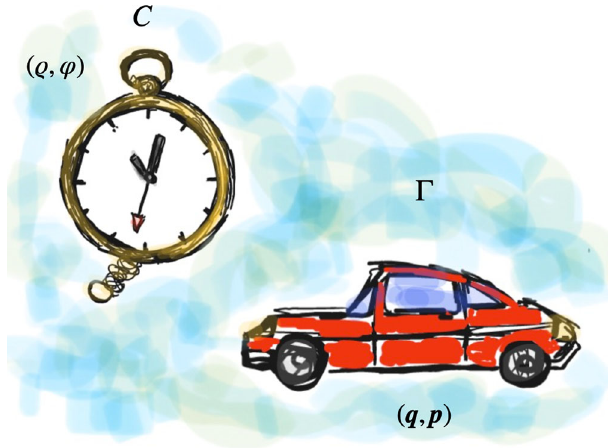
Fig. 3 A classical clock for a classical system. The state of the classical clock C is identi fi ed by the real variables ϱ and φ , while couples of canonically conjugated variables ( q , p ) are used to describe the state of the classical system Γ